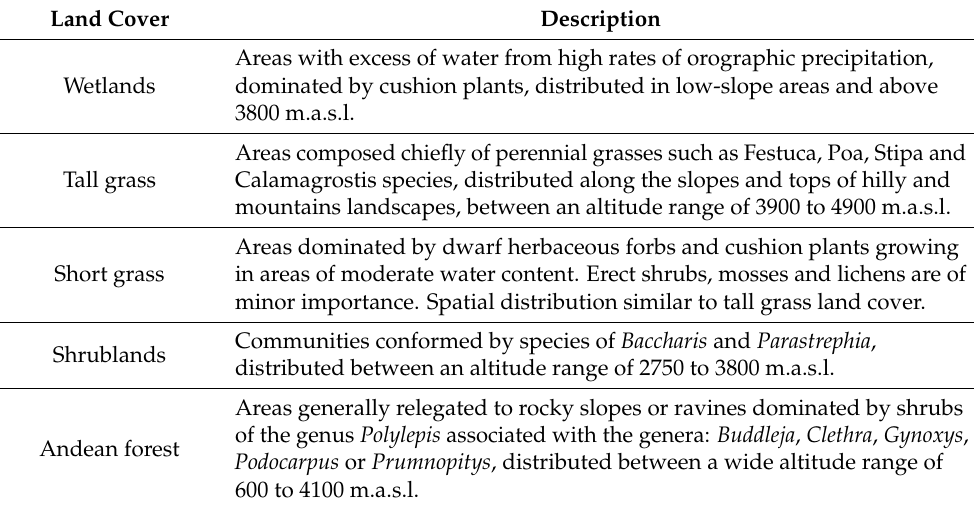
Table 1. Vegetation land cover classes identified in RPNYC [24,25].